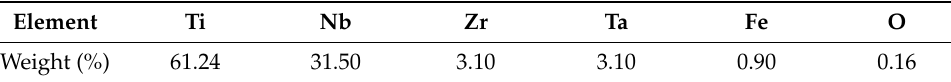
Table 1. The chemical composition of Ti-Nb-Zr-Ta-Fe-O gum alloy. Element Ti Weight